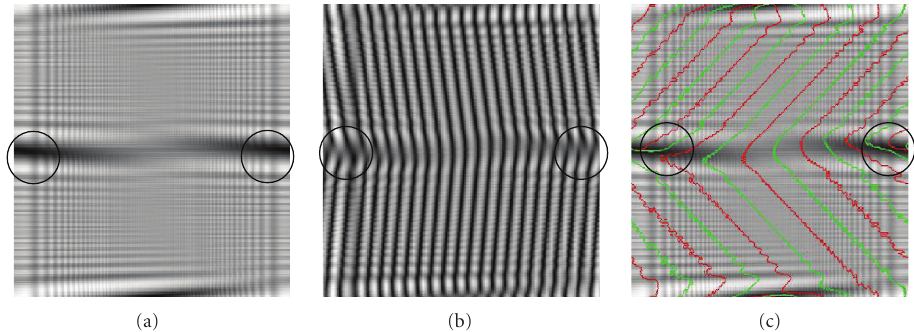
Figure 9: (a) Simulated intensity distribution for linear array for two oppositely inclined phase ramps with di ff erent tilt. (b) Simulated interference patterns to check formation of optical vortices. (c) Simulated results for zero crossing of real and imaginary for two oppositely inclined phase ramps with di ff erent tilt. In the figure green line represents real part and red line represents imaginary part of the wave